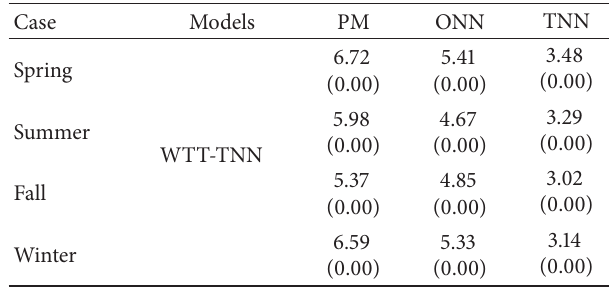
Table 6: Wilcoxon signed-ranktestcomparing between WTT-TNN and PM, ONN, and